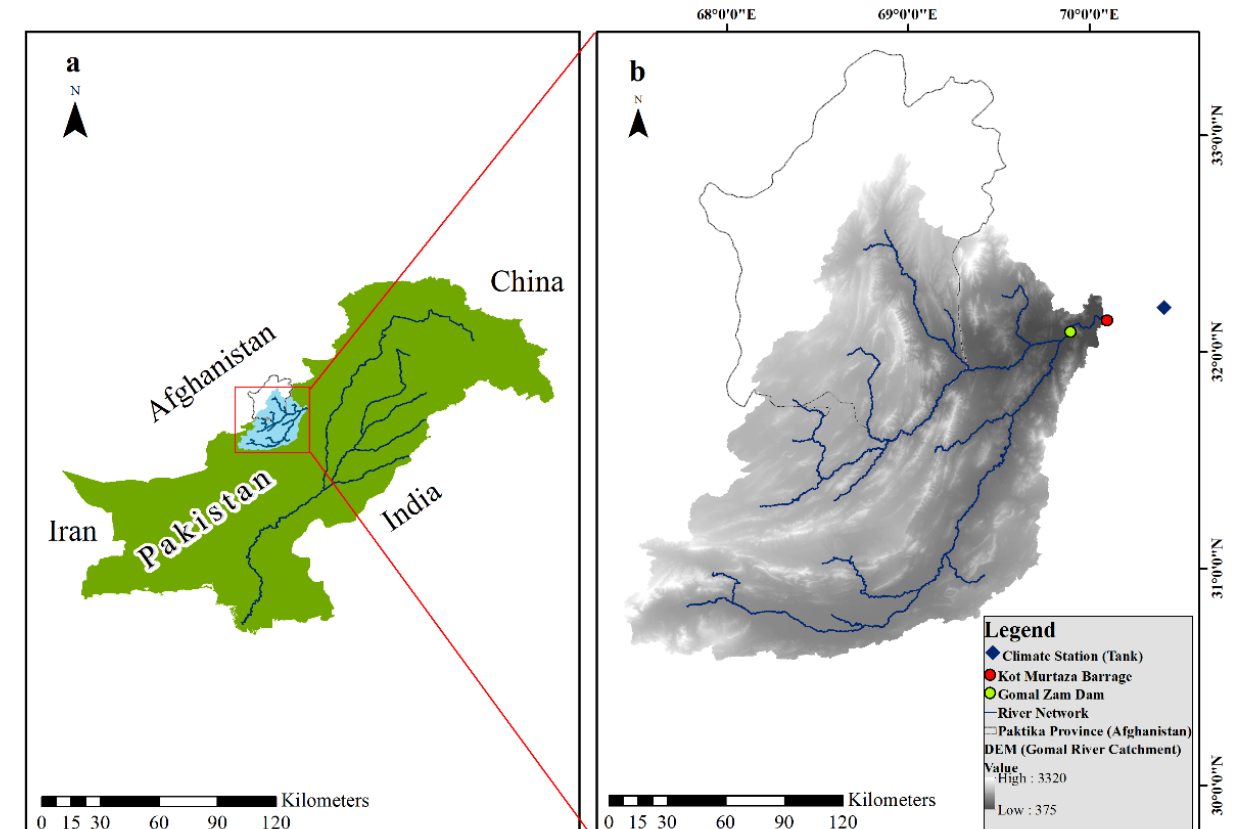
Figure 1. Map of Gomal Zam River catchment at Kot Murtaza Barrage: ( a ) Gomal River catchment sharing Pakistan and Afghanistan, ( b ) Gomal River catchment, GZD site, stream and precipitation gauging sites .